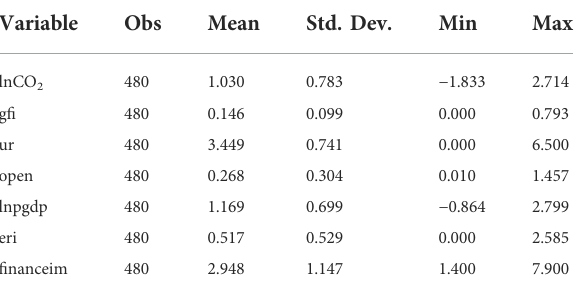
TABLE 1 Descriptive statistics.